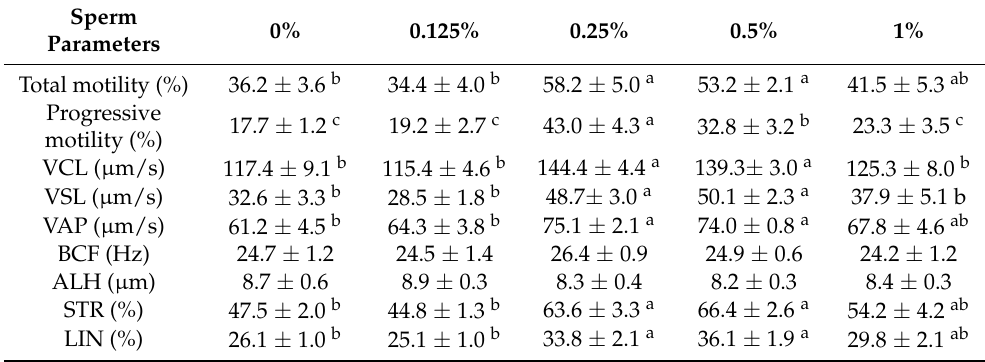
Table 1. Effect of CPLL on post-thaw boar sperm motility parameters measured with